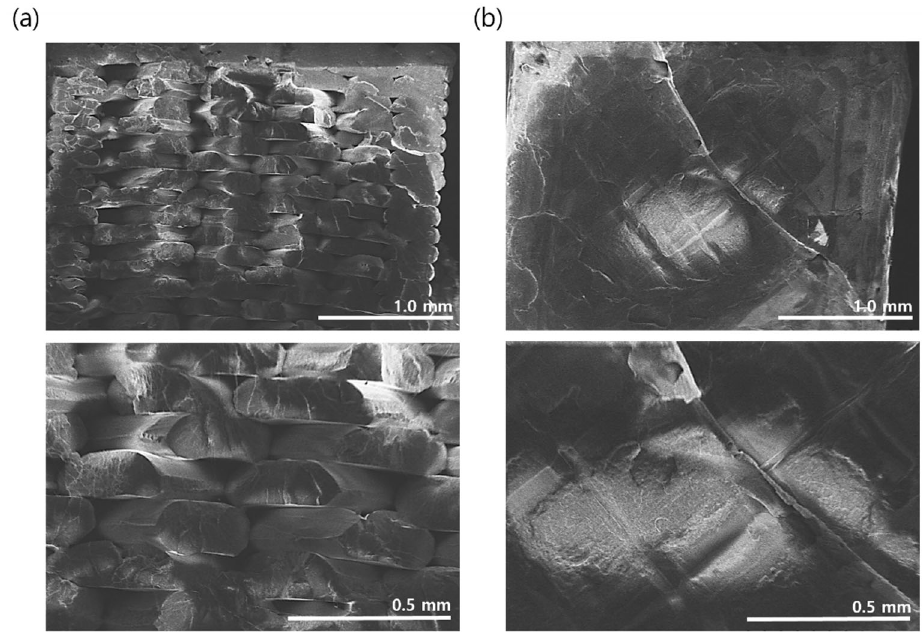
Figure 8. Fracture surface morphology of 3D-printed specimens after the tensile test: ( a ) horizontally and ( b ) vertically fabricated specimens.